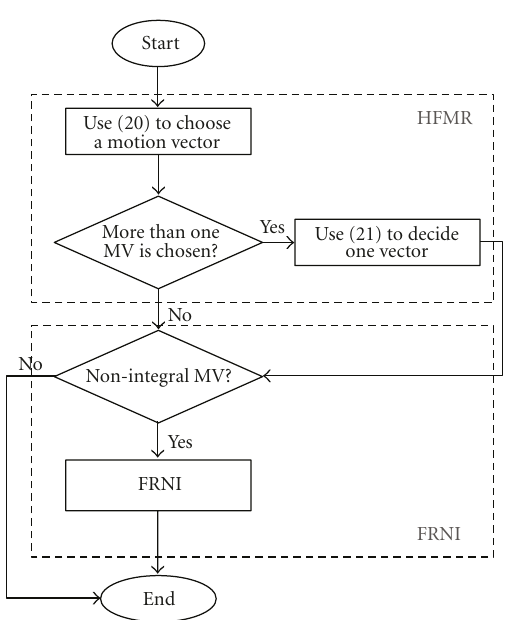
Figure 11: Flow chart of the entire proposed HFMR and FRNI.